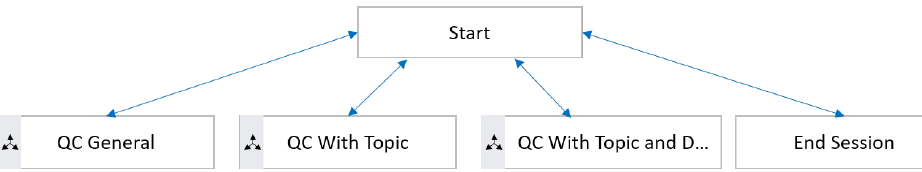
Figure 3. Start flow of the